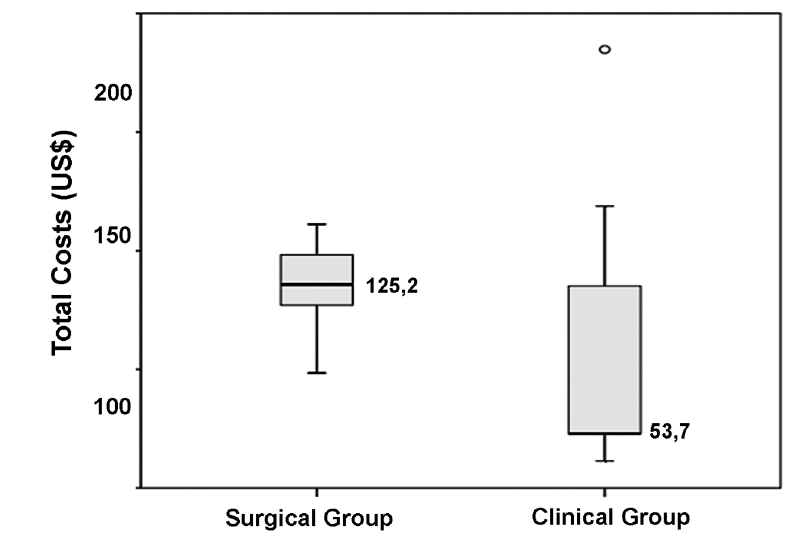
Figure 4 – Box plot of the analysis of total costs in both groups.